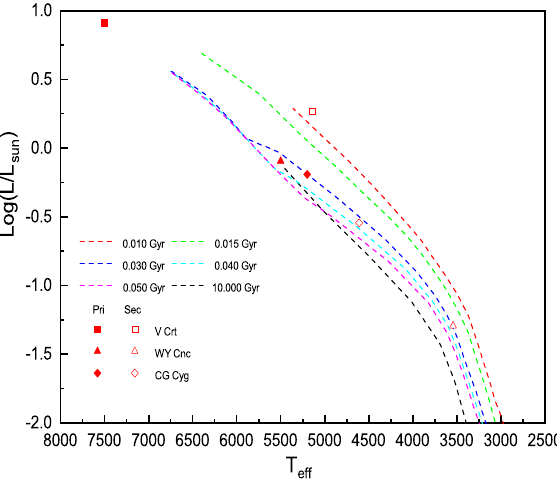
Figure 9. Position of the components of the three eclipsing in T ef f -log ( L / L (cid:12) ) diagrams. The dash lines in deferent colors represent different isochrones of the solar chemical